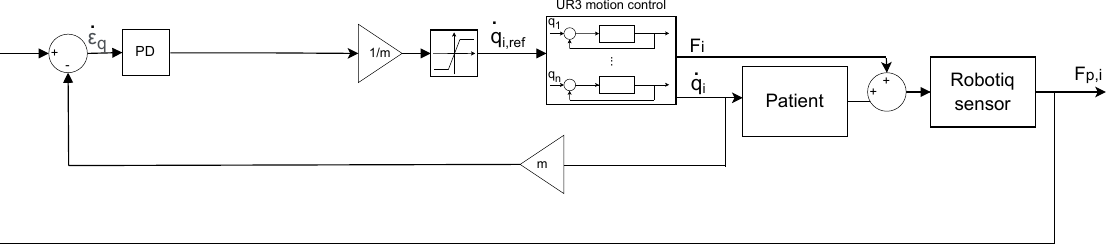
Figure 6. General control block diagram for active-assisted rehabilitation